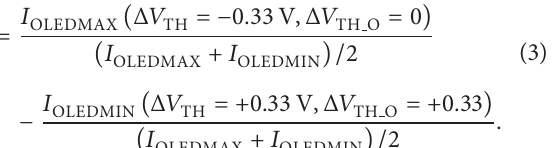
= ±0.33 V and Δ𝑉 TH